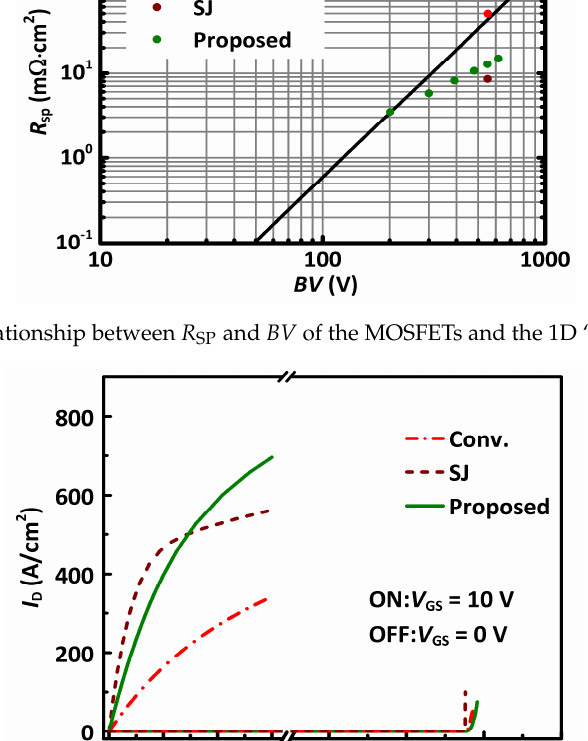
Figure 5. Relationship between R SP and BV of the MOSFETs and the 1D “silicon limit.”